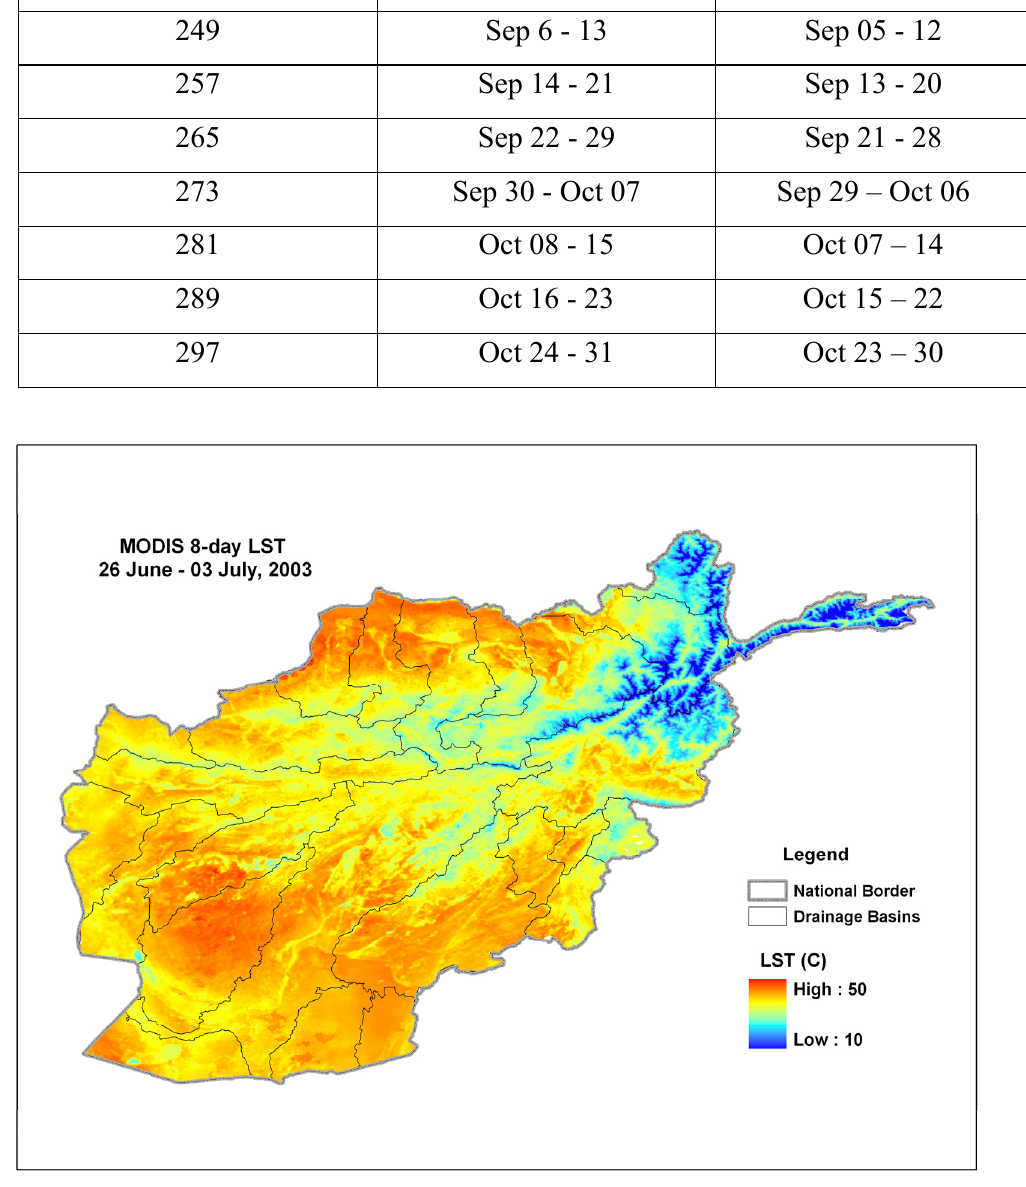
Figure 2. An 8-day composite of MODIS Land Surface Temperature (LST, o C) in late June/early July